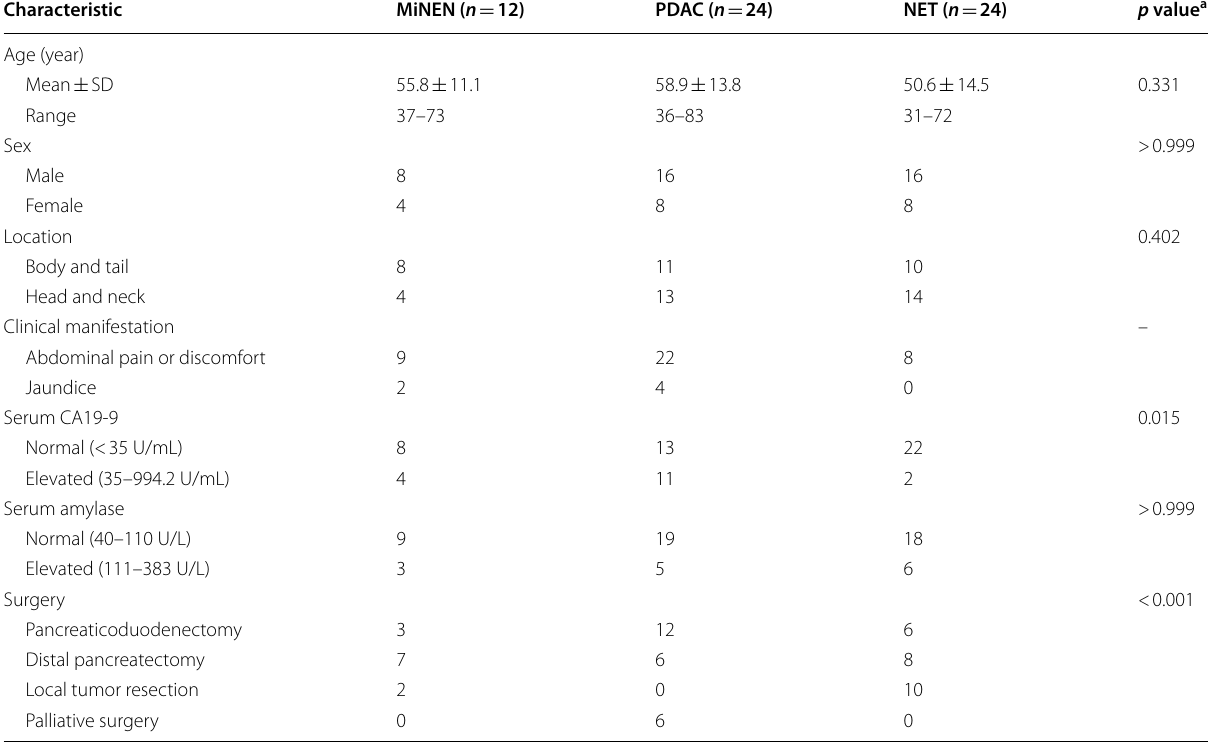
Table 1 Clinicopathological characteristics of patients with pancreatic MiNEN, PDAC, and